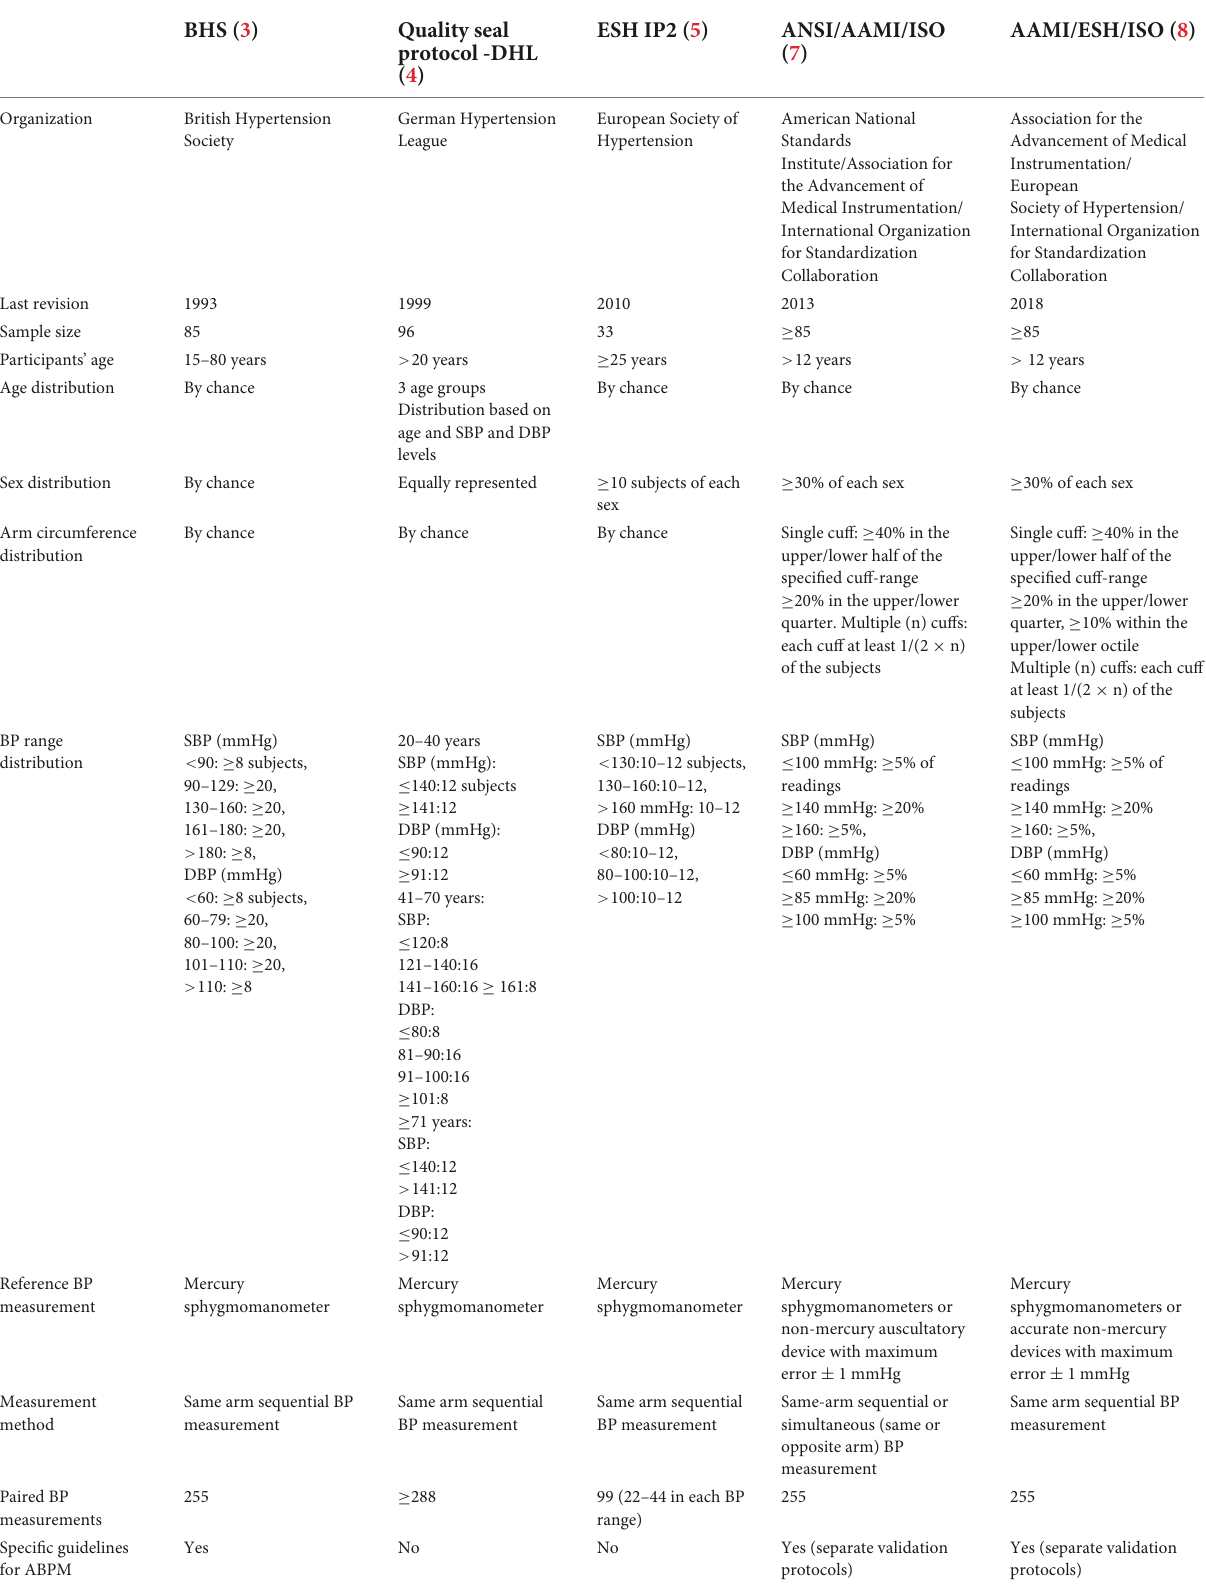
TABLE 1 Comparison of validation protocols for blood pressure (BP) measuring